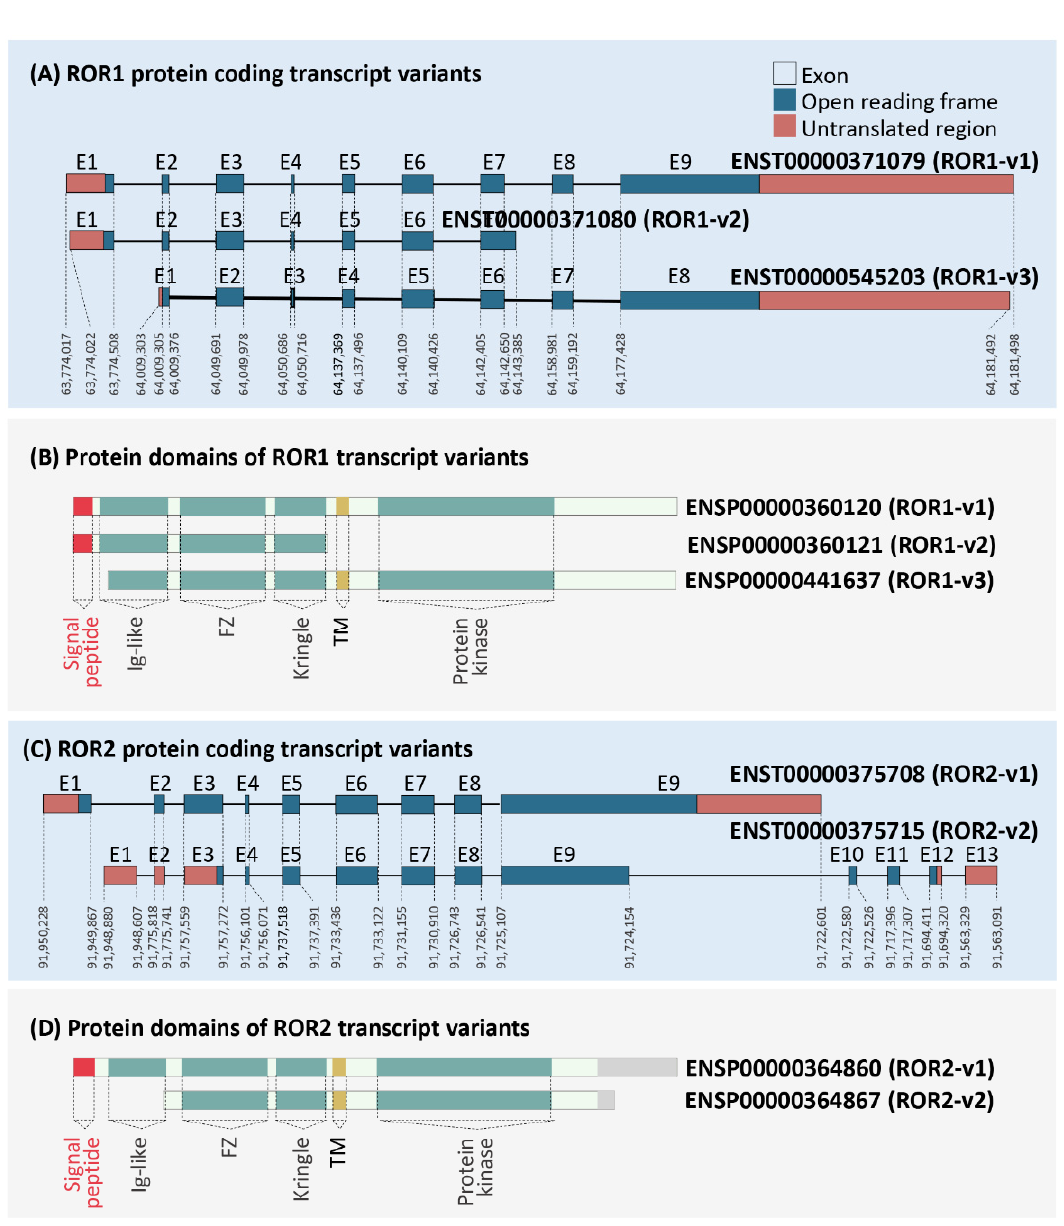
Figure 1. Analysis of protein-coding ROR1 and ROR2 isoforms. Coding transcript and protein sequences for ROR1 ( A , B ) and ROR2 ( C , D ). Exon (E) numbers are represented above and genomic locations for ROR1 and ROR2 on chromosomes 1 and 9, respectively are provided below each exon. Protein domain structures identified by uniport and bioinformatic SP prediction have been highlighted (translation IDs for the respective transcript variants are provided beside the structure).